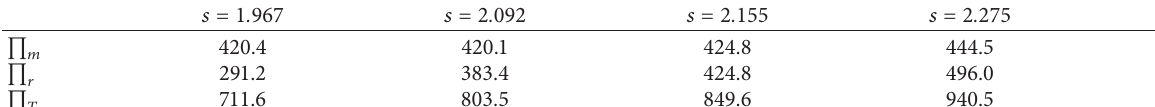
� 0 . 06 and α � 0 . 5 ) . 1 2